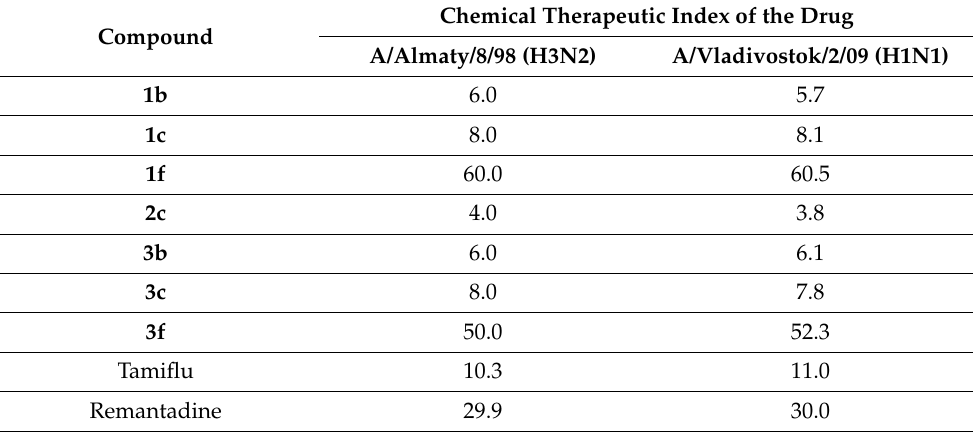
Table 5. Virus-inhibiting activity of compounds against influenza viruses. Chemical Therapeutic Index of the Drug Compound A/Almaty/8/98 (H3N2) A/Vladivostok/2/09